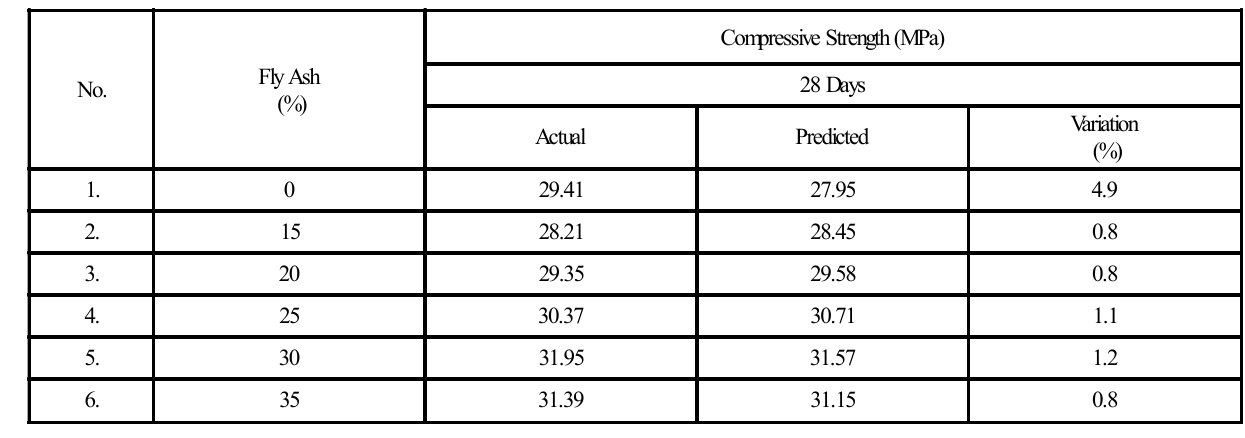
TABLE 6. PERCENTAGE VARIATION IN 28-DAYS COMPRESSIVE